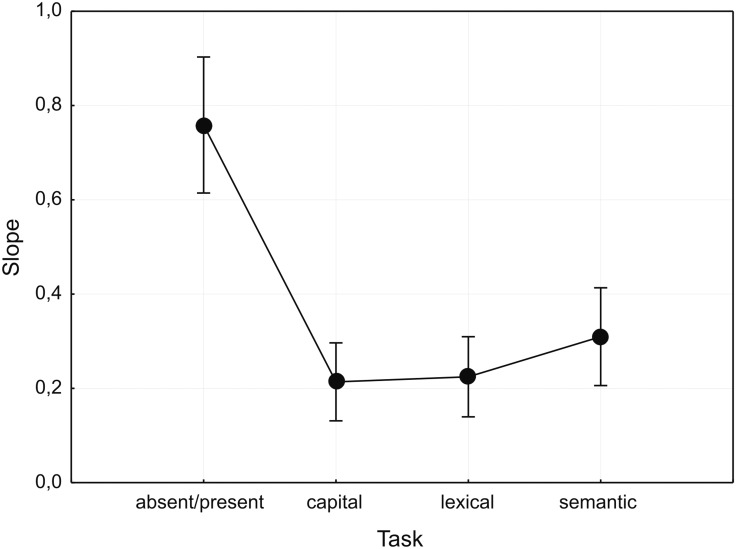
Slopes of the psychometric functions, grouped by factor TASK. Depicted are mean values ± 95% confidence interval.